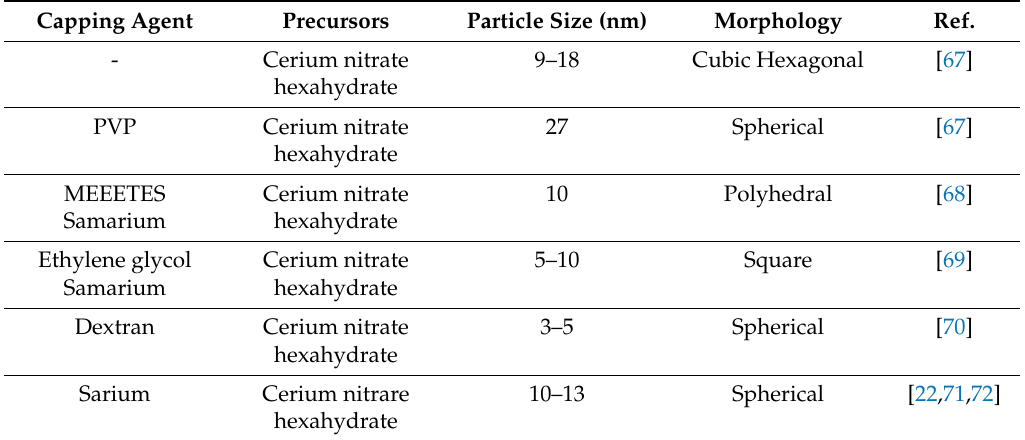
Table 1. Table showing the synthesis of cerium oxide nanoparticles using the precipitation method. Capping